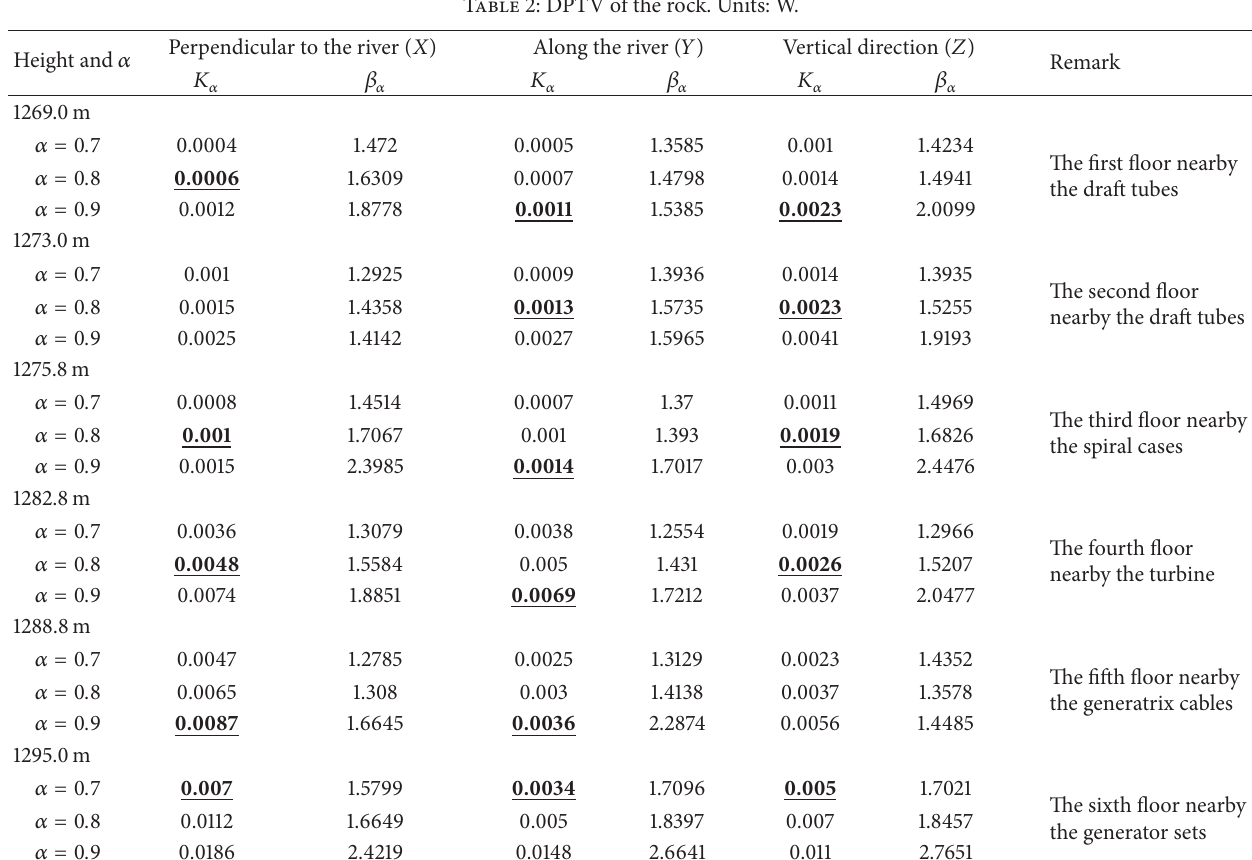
Table 2: DPTV of the rock. Units: W.